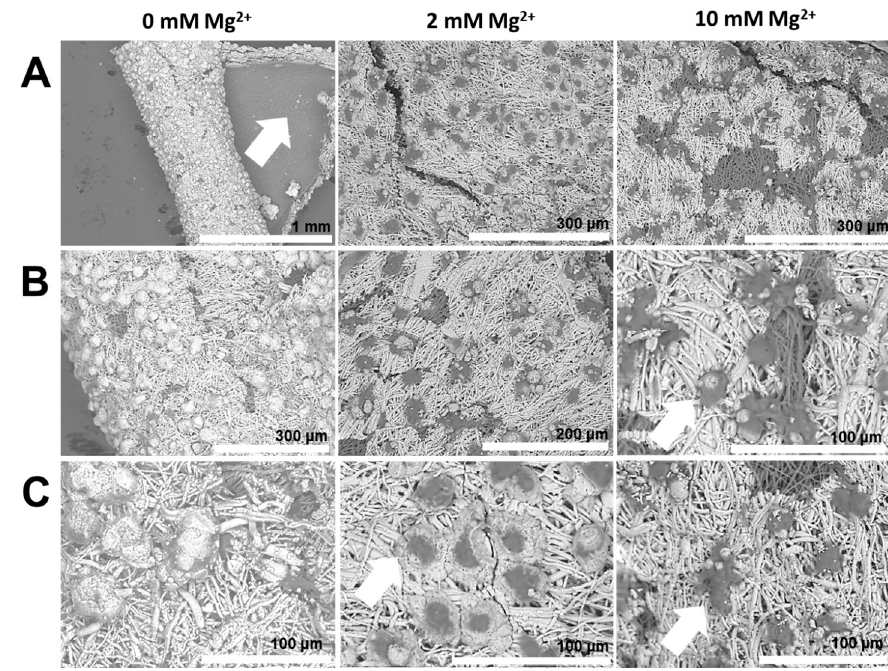
Figure 6. Representative SEM images of outer surfaces of egg shell membranes mineralized in the presence of poly(acrylic acid) (PAA) 5000 (50 ppm) and different Mg 2+ contents. Arrows indicate ( A ) membrane curvature post-mineralization and ( B , C ) preferential mineralization of collagen fibrils and active exclusion of mammillae from mineral growth.